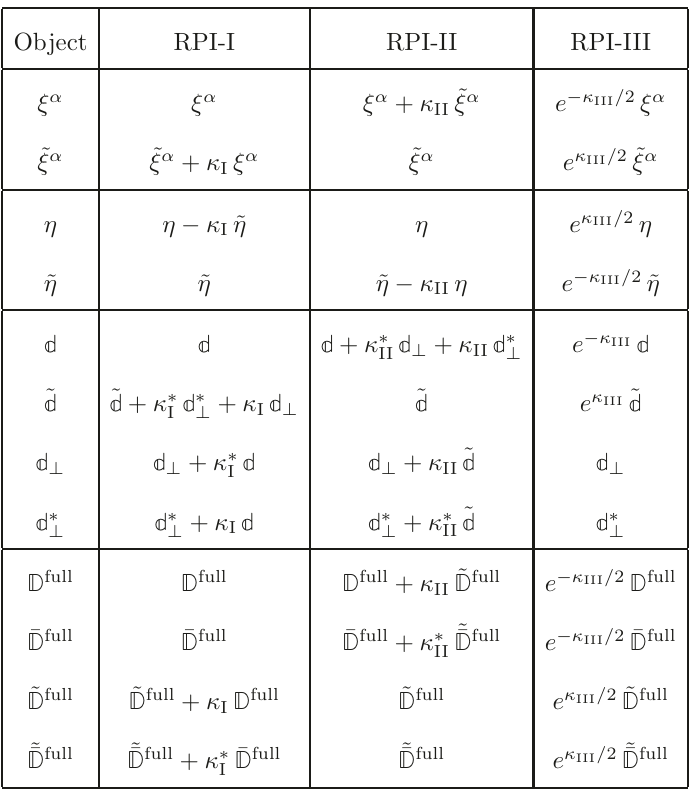
Table 1 . The RPI transformations of the superspace coordinates and derivative operators. Note that prior to setting ˜ η = 0, the RPI-II transformations are linear. These transformations make it clear that the chiral projector in eq. (2.10) is RPI-III